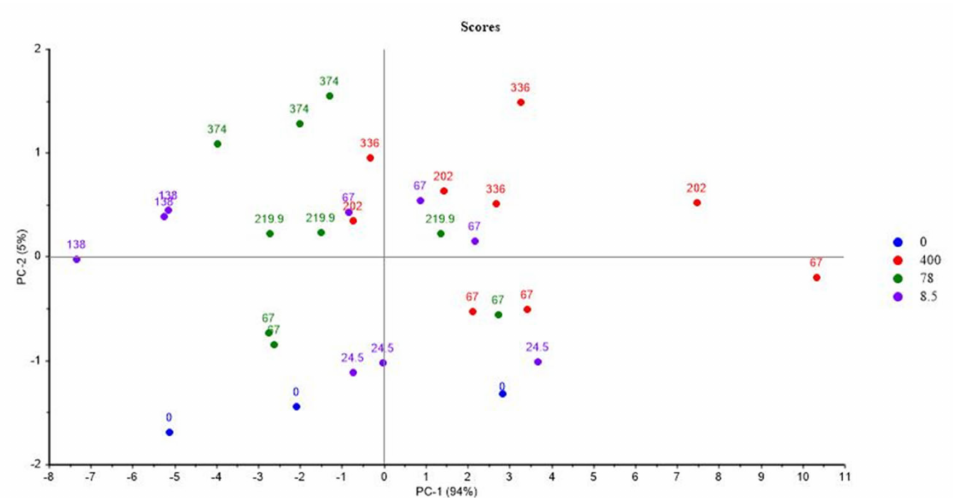
Figure 11. PCA results on Mod6: UJV irradiation dose rate (Gy/h) with location of the second step of irradiation.